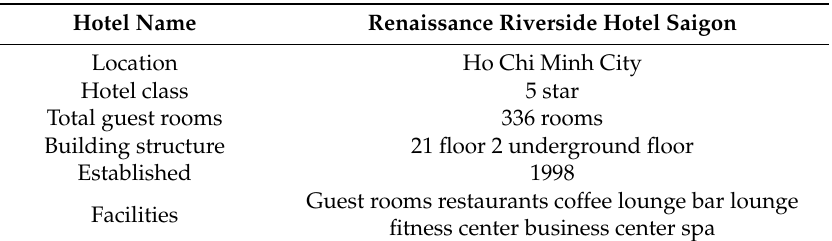
Table 1. Description of the hotel.